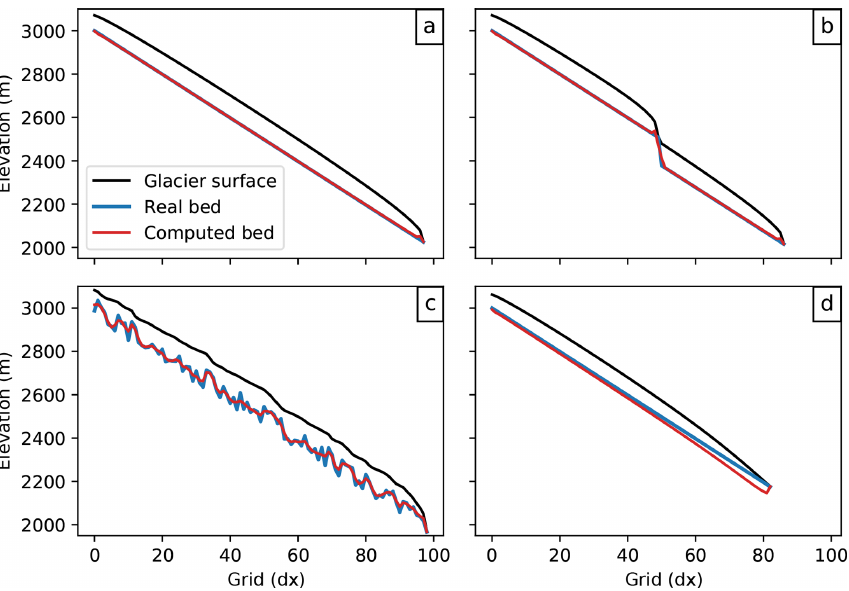
Figure 5. Idealized inversion experiments: we compute the bed topography from the surface elevation obtained from a flow-line model applied to a predefined bed topography. (a–c) Glacier grown to equilibrium with different bed topographies (flat, cliff, random). (d) Transient experiment with a shrinking glacier. The same mass-balance profile is used for all experiments (linear gradient of 3mmw.e.m − 1 , ELA altitude of 2600ma.s.l.). For (d) , the glacier is first grown to equilibrium then shrunk for 60 years after an ELA shift of +